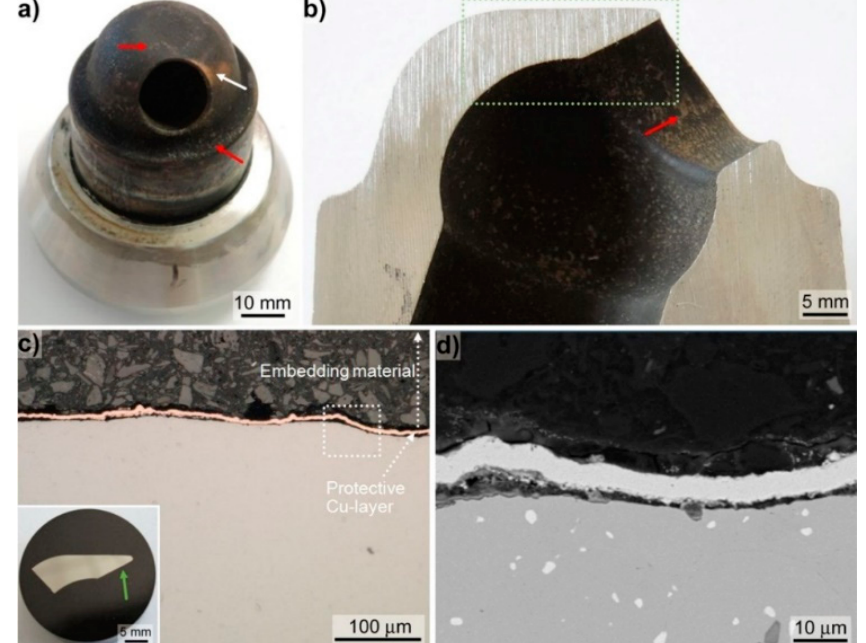
Figure 7. Post analysis of the prechamber after the engine test; ( a ) image of the complete prechamber; ( b ) section of the prechamber showing the opening towards the combustion chamber; the green rectangle indicates the position of the metallographic section presented in the insert of ( c ). ( c ) Light optical images taken approximately at the position as indicated by the green arrow in the insert. ( d ) BSE-SEM images taken in BSE-mode at the position indicated by the white dotted rectangle in ( c ).